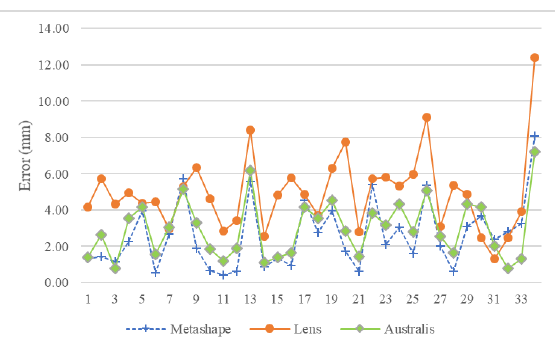
Figure 8: Check-point error on Check_Field_2.